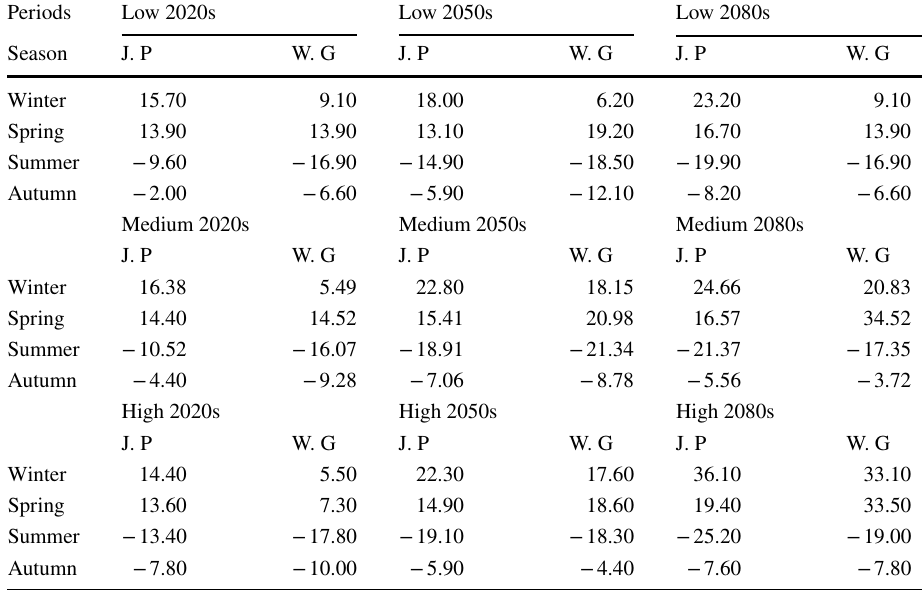
Table 3 Percentage changes in streamflow using the UKCP09 joint probability (J.P) change factor central estimates (highest probability level) and the UKCP09 weather generator (W.G) for different climate change scenarios